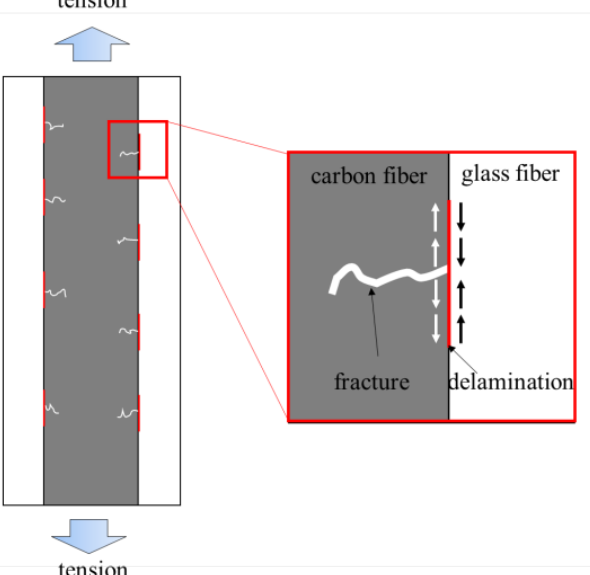
Figure 15. Schematic diagram of the synergistic effect for the structure with glass fiber sandwiching carbon fiber.